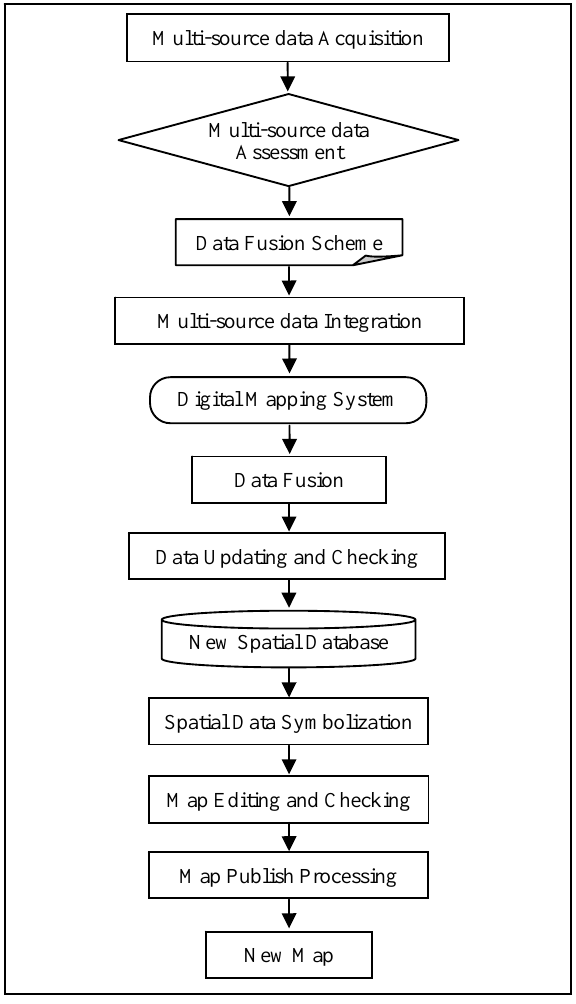
Figure 2. The general framework and